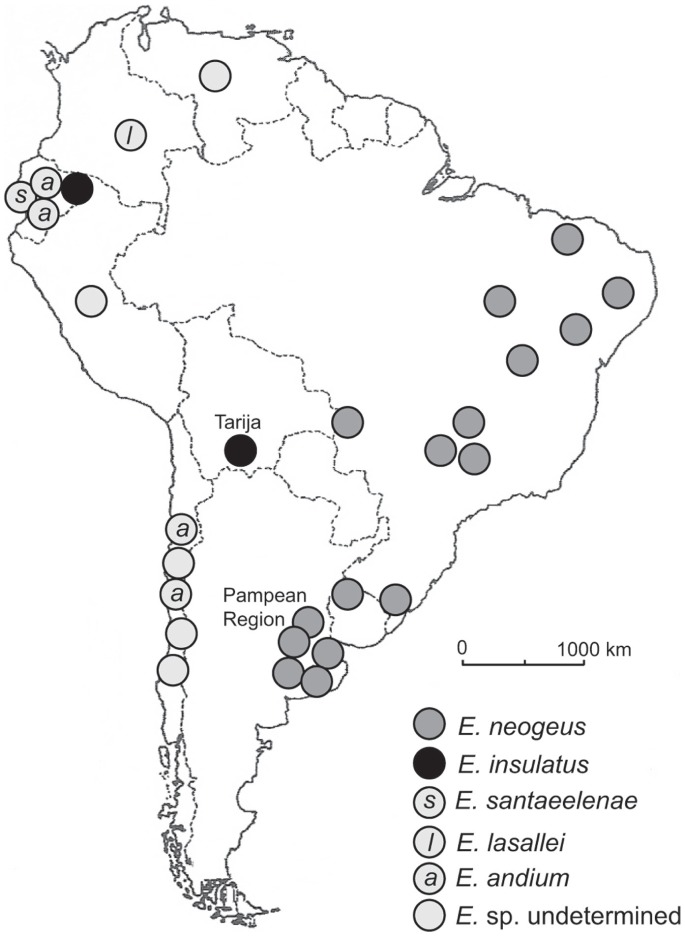
Map of Equus localities in South America.This map is modified, and includes all recognized species according to Alberdi and Prado [4]. Some points, e.g., Equus sp. from Colombia, actually represent multiple localities [5]. Of relevance to this paper, the species E. insulatus occurs from Tarija, Bolivia and one other locality, Rio Chiche, Ecuador [4]–[6]. The locality from Ecuador is reported to be late Pleistocene, but otherwise lacks precise, independent chronostratigraphic control.